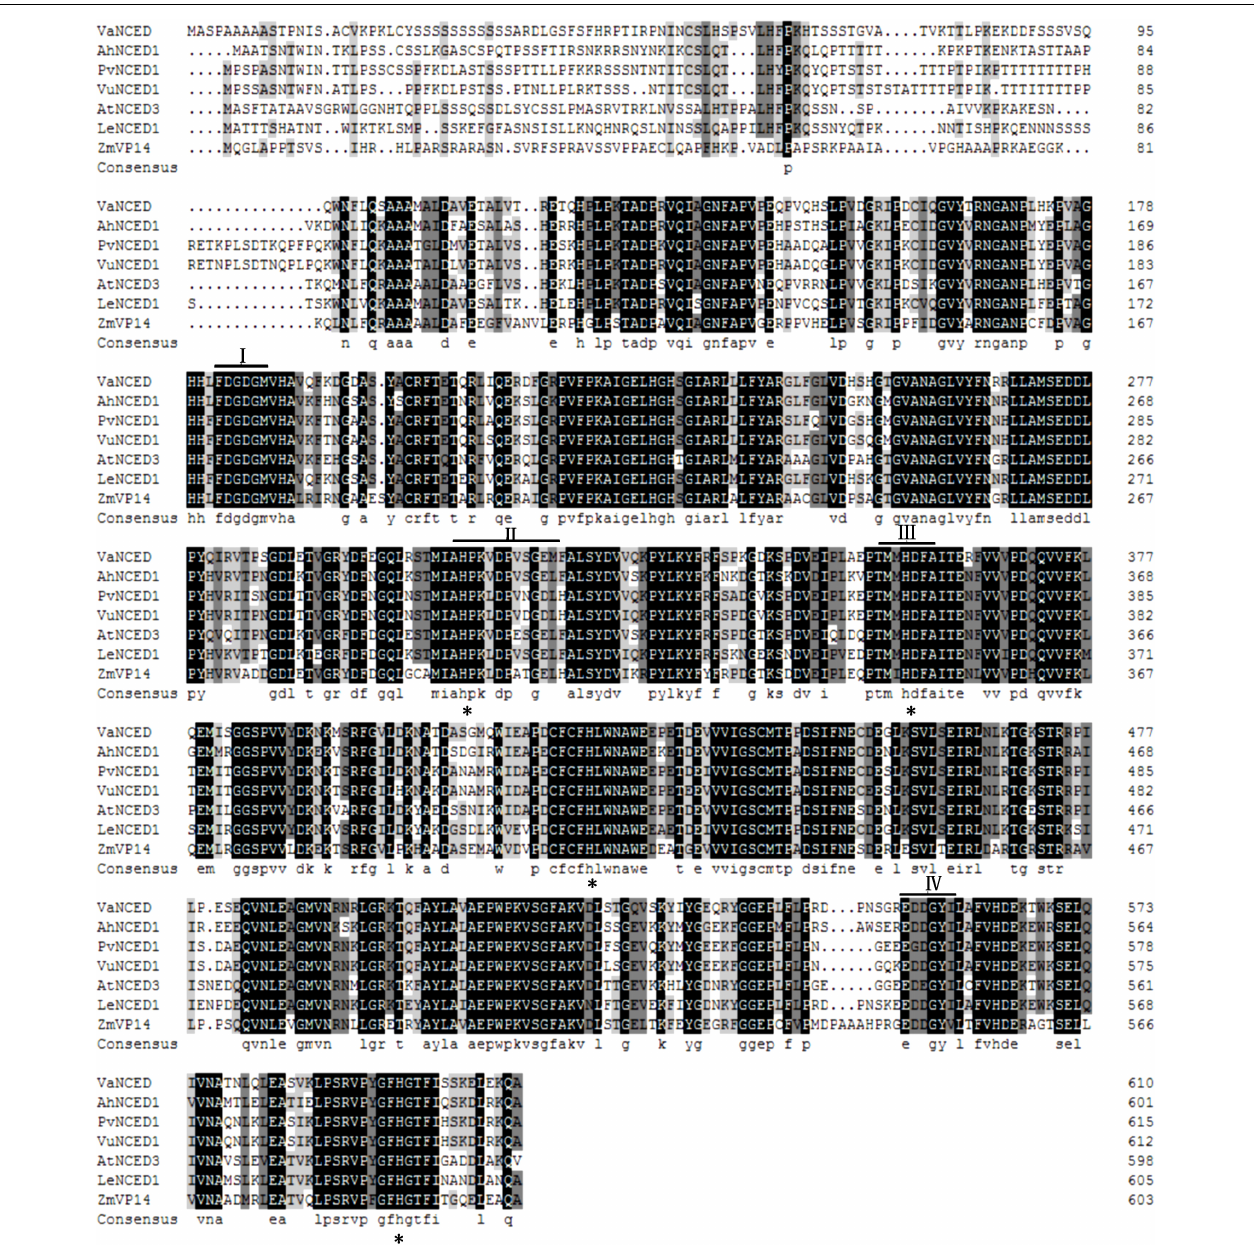
FIGURE 2 | Multiple alignments of the deduced amino acids of VaNCED1 with other NCEDs from bean PvNCED1 (AF190462), cowpea VuNCED1 (AB030293), peanut AhNCED1 (AJ574819), tomato LeNCED1 (Z97215), Arabidopsis AtNCED3 (AY056255), and maize ZmVP14 (U95953). Black color represents the homologous regions. I, II, III, and IV indicate the conserved sequences. The four histidine residues are marked with asterisks.